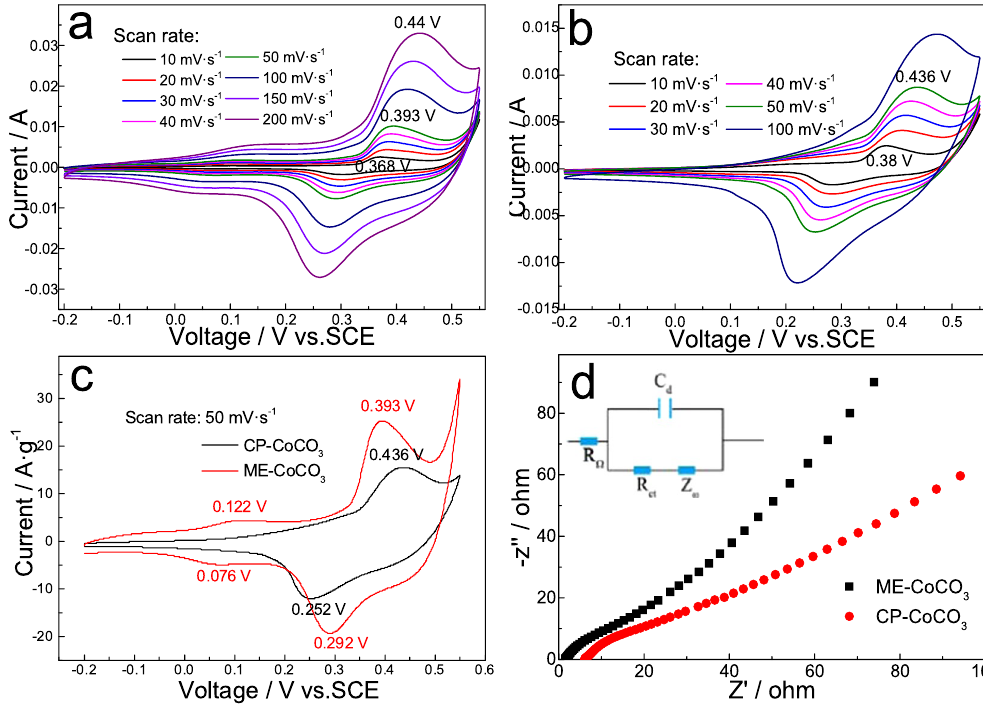
Figure 5. CV curves of ( a ) ME-CoCO 3 , ( b ) CP-CoCO 3 at different scan rates and ( c ) both of them at the scan rate of 50 mV·s − 1 , and ( d ) their EIS